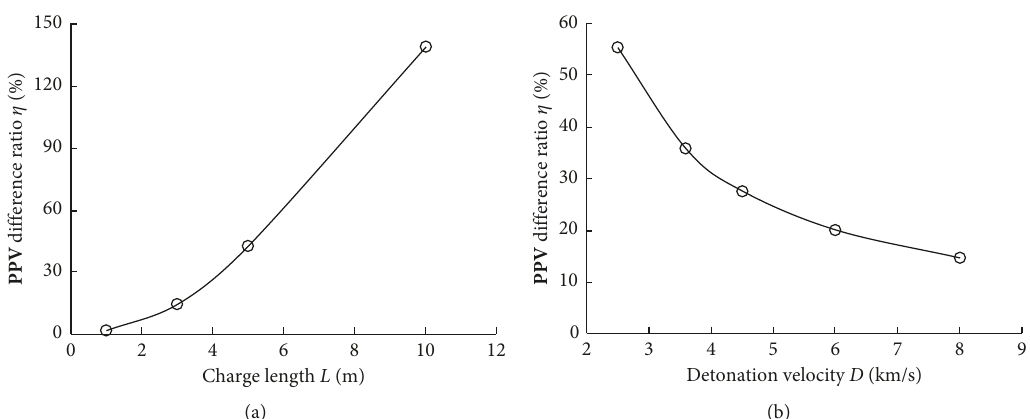
Figure 15: Sensitivity of the charge length L and the detonation velocity D affecting the blast vibration field. PPV difference ratio η against (a) the charge length L and (b) the detonation velocity D .